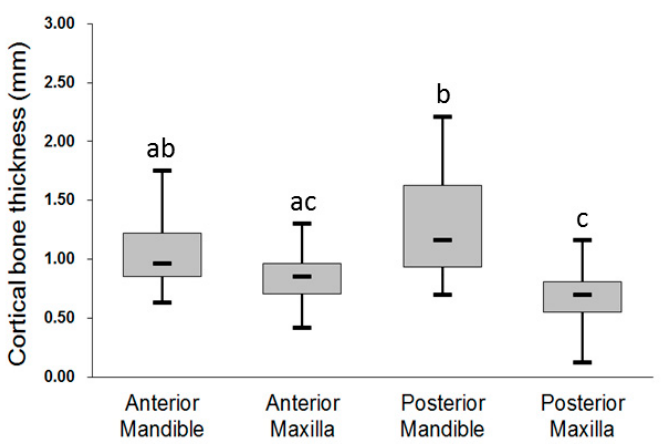
Figure 3. Thickness of the crestal cortical bone at the four jawbone regions for the older group. Post hoc pairwise comparisons were conducted using Tukey’s test; use of the same letter (a, b, c) indicates no significant difference at the 0.05 level.